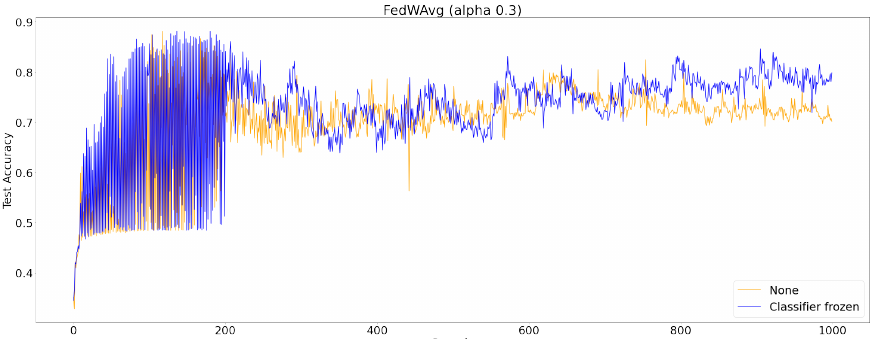
Figure 3. Test accuracy over communication rounds with parameter freezing. The blue line is FedWAvg with classifier frozen, and the orange line is FedWAvg without parameter